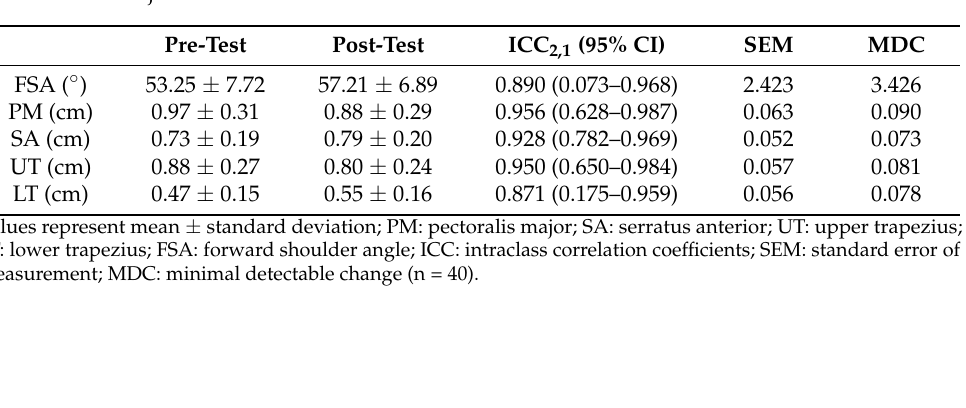
Table 4. Intra-rater reliability for assessing the muscle thickness composing the forward shoulder posture in all subjects.